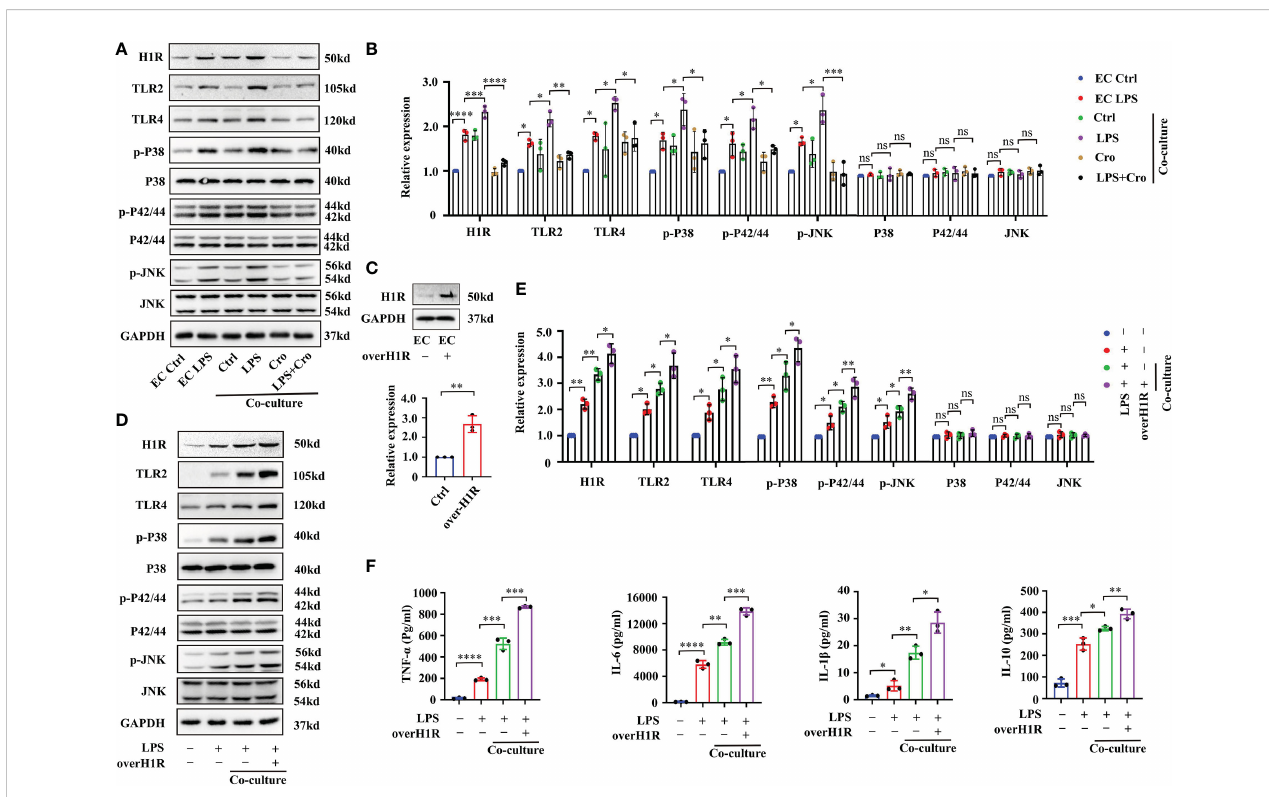
FIGURE 7 MC-secreted histamine ampli fi ed the LPS-induced in fl ammatory response in BMVECs through the H1R-TLR2/4-MAPK signaling pathway. (A) Expression levels of TLR2/4 and MAPK signaling pathway proteins (P38, P42/44 and JNK) in P815-bEnd.3 co-culture system were analyzed by Western blot (n=3). (B) Expression levels of TLR2/4 and MAPK signaling pathway proteins (P38, P42/44 and JNK) in the P815-bEnd.3 co-culture system were quanti fi ed and normalized to GAPDH levels (n=3). (C) Expression levels of H1R were checked by Western blot after bEnd.3 cells were over-expressed with H1R (n=3). (D) Expression levels of TLR2/4-MAPK signaling pathway proteins were checked by Western blot after bEnd.3 cells were over-expressed with H1R (n=3). (E) Expression levels of TLR2/4-MAPK signaling pathway proteins were quanti fi ed and normalized to GAPDH levels after bEnd.3 cells were over- expressed with H1R (n=3). (F) ELISA showed the changes of TNF- a , IL-6, IL-1 b and IL-10 in medium supernatant after bEnd.3 cells were over-expressed with H1R (n=3). LPS, Lipopolysaccharide; MCs, Mast cells; H1R, histamine 1 receptor; TLR, Toll-like receptor; MAPK, Mitogen-activated protein kinases; (ns, no signi fi cance, * p < 0.05, ** p < 0.01, *** p < 0.001, **** p <